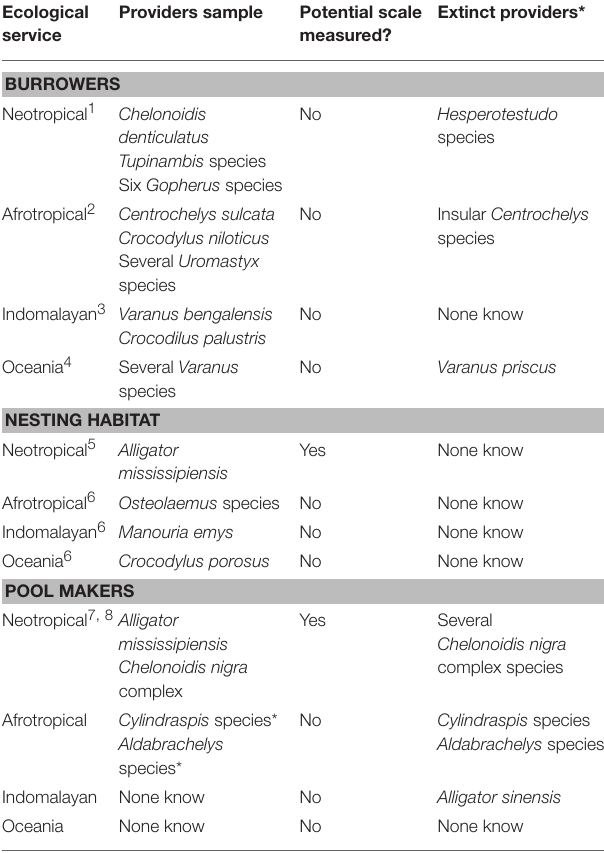
TABLE 4 | Examples of reptiles as ecosystem engineers. Ecological